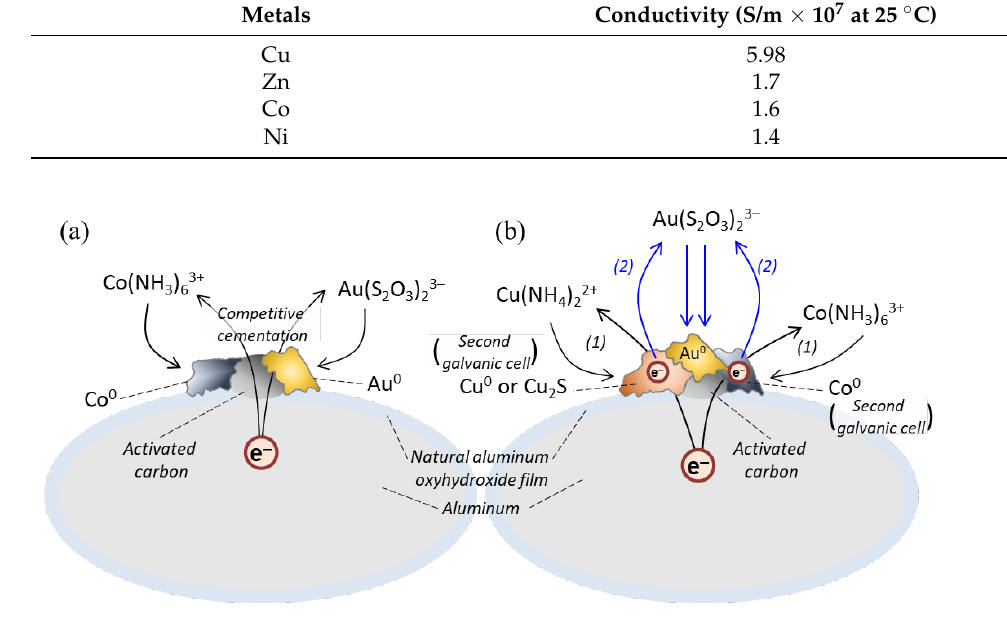
Figure 9. Schematic diagram of the competitive electron transfer from ZVAl to Cu-ammine, Co- ammine, and Au-thiosulfate complex ( a ) without and ( b ) with Cu ions in the system.